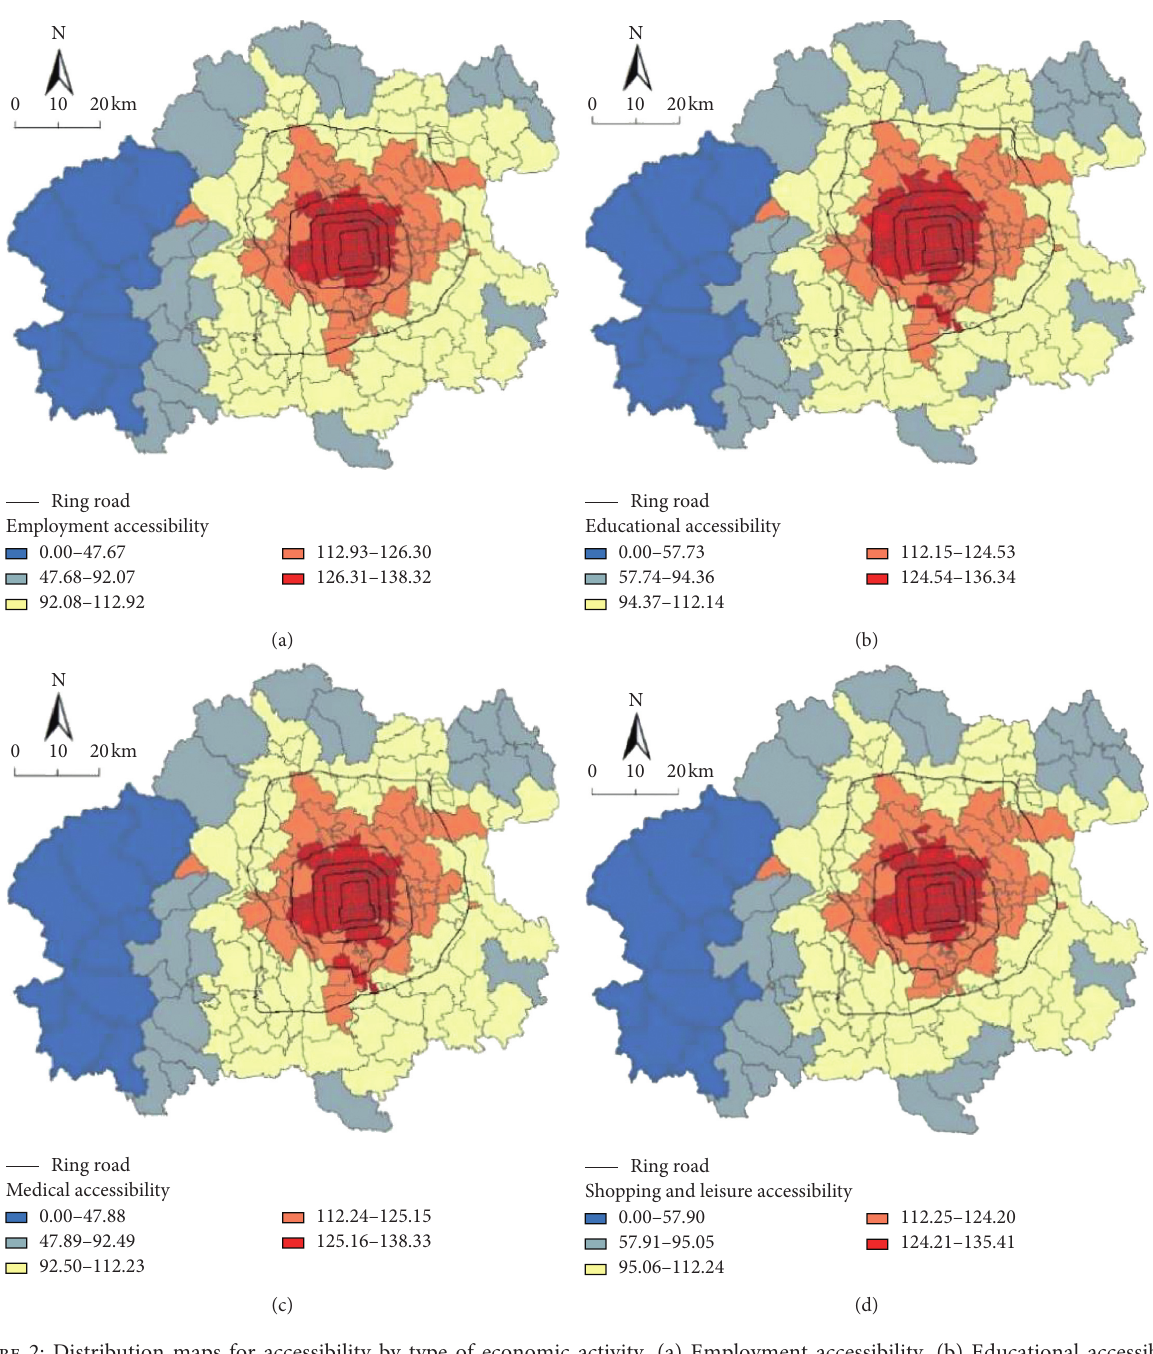
Figure 2: Distribution maps for accessibility by type of economic activity. (a) Employment accessibility. (b) Educational accessibility. (c) Medical accessibility. (d) Shopping and leisure